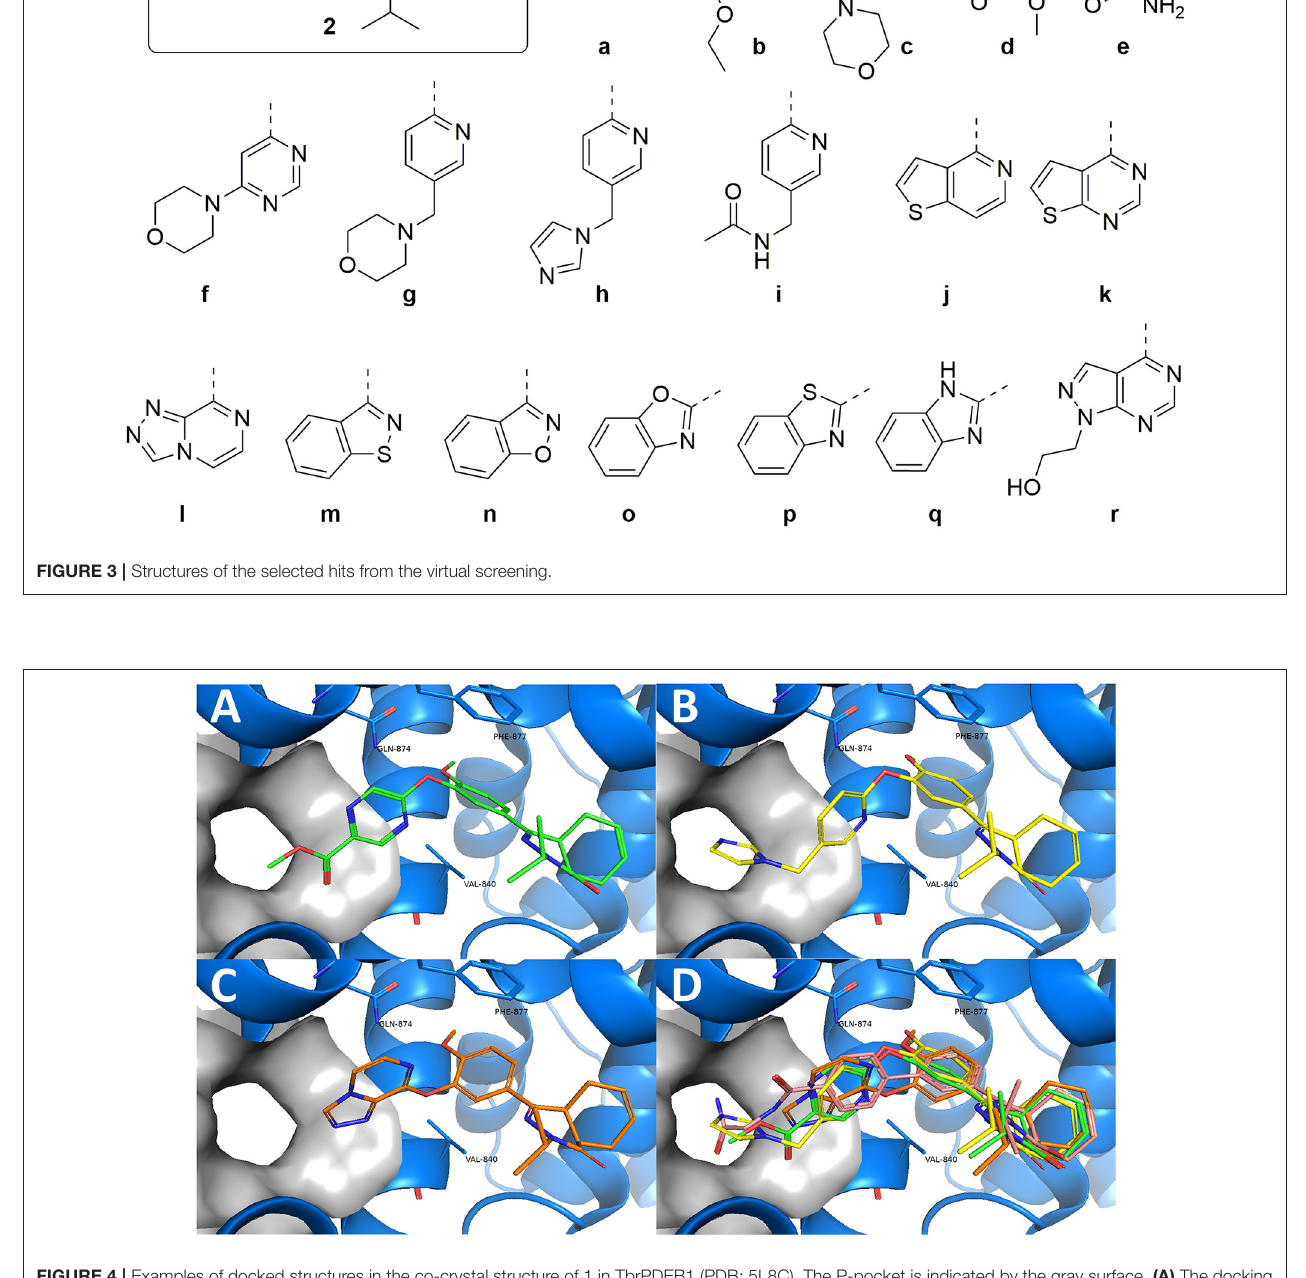
FIGURE 4 | Examples of docked structures in the co-crystal structure of 1 in TbrPDEB1 (PDB: 5L8C). The P-pocket is indicated by the gray surface. (A) The docking pose of pyrazine 2d (green). (B) The docking pose of 2h (yellow). (C) The docking pose of 2l (orange). (D) Overlay of the different docking poses of 2d, 2h, and 2l with reference compound 1